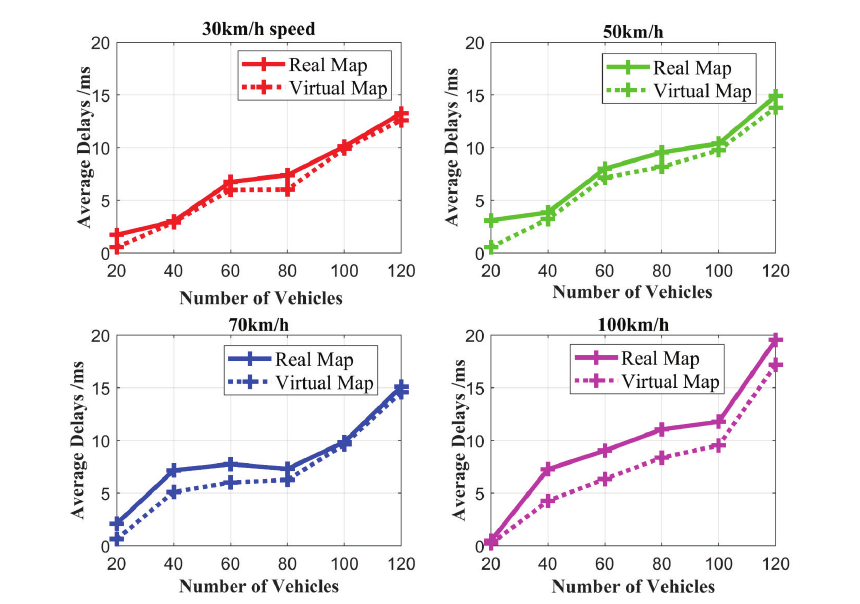
Figure 8. Transmission delay of vehicle cross-regional identity authentication.